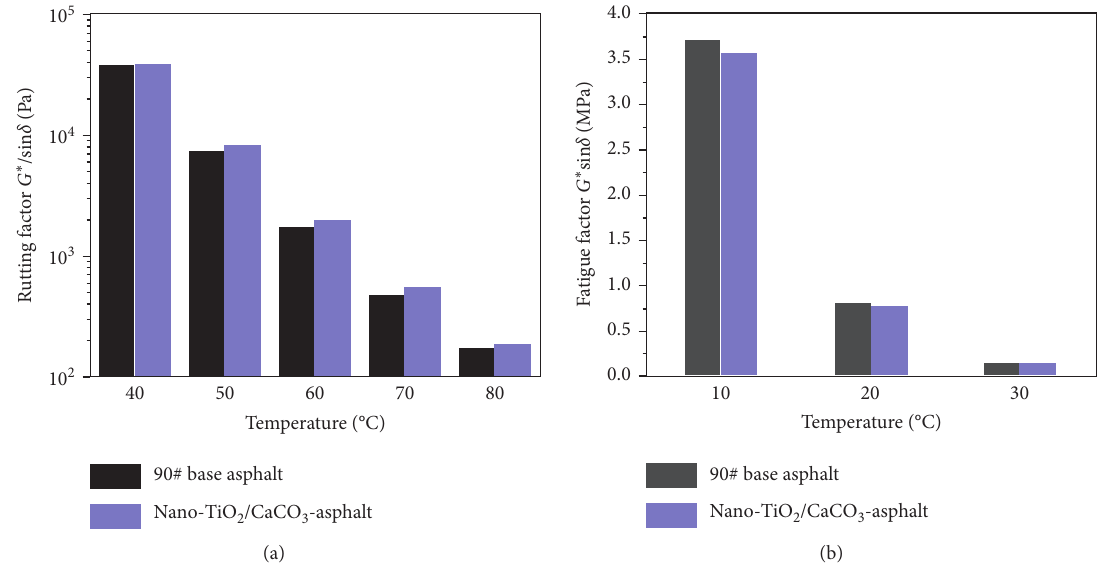
Figure 8: Deformability of base bitumen and nano-TiO